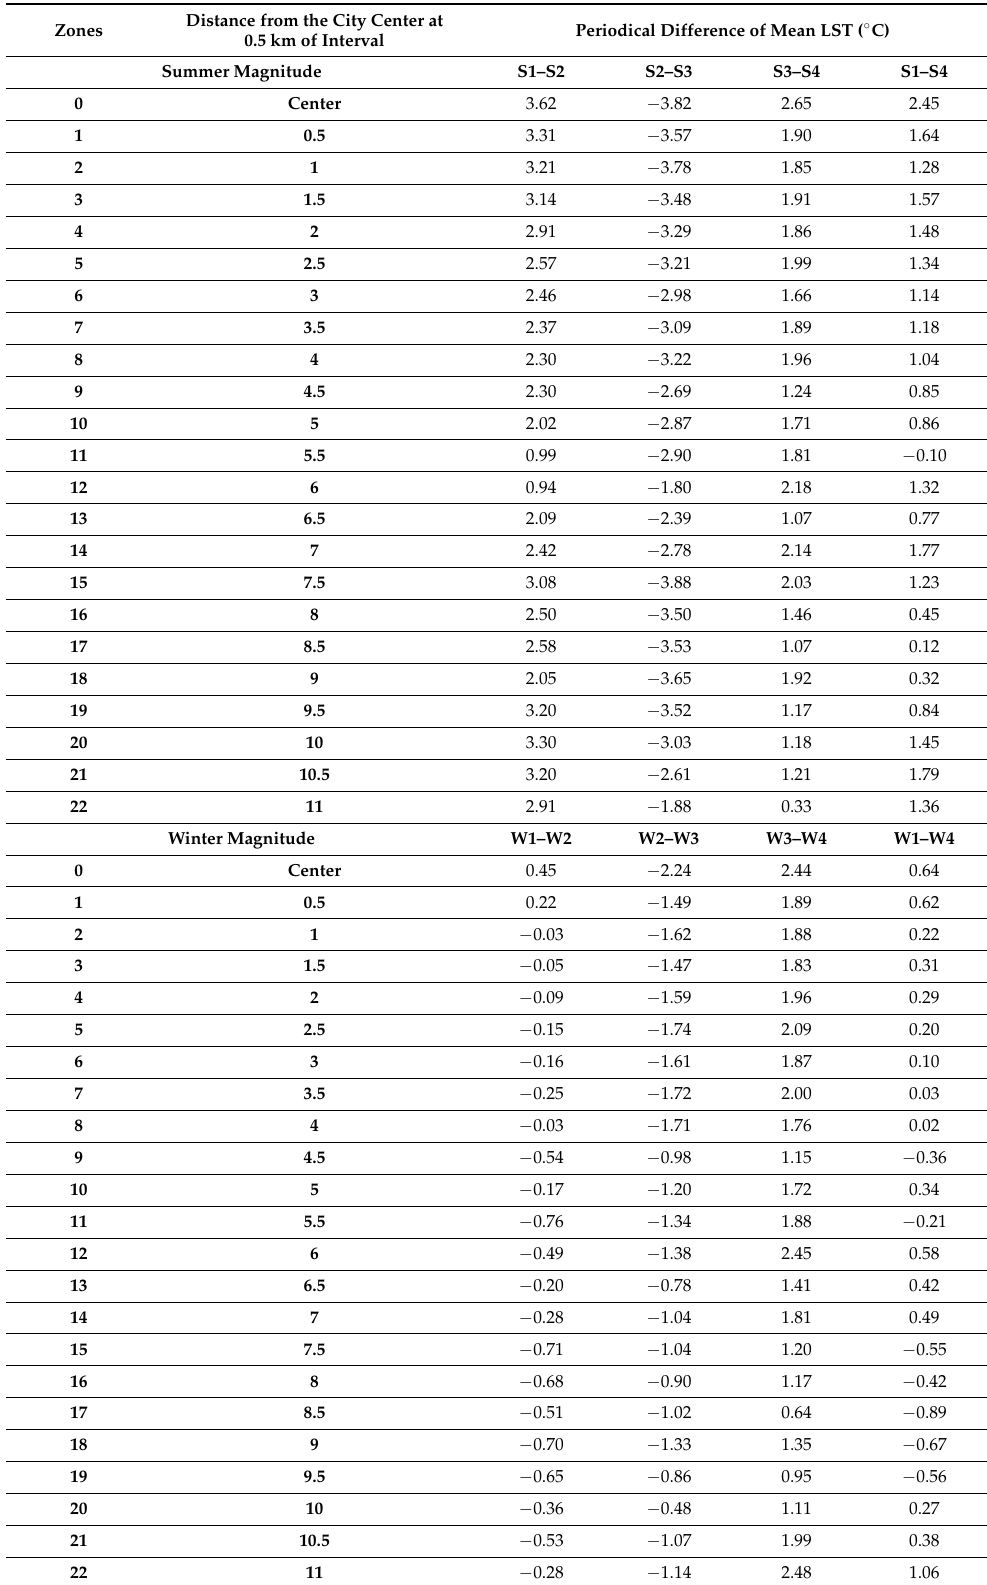
Table 5. Periodical LST magnitudes based on multiple ring buffers from the city center to the periphery at 0.5 km of intervals in Prayagraj city